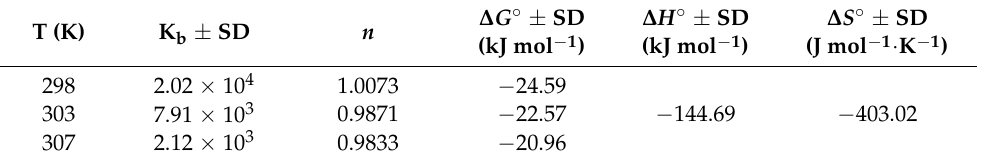
Table 3. Binding parameters and thermodynamic parameters for BSA-ETB system. T